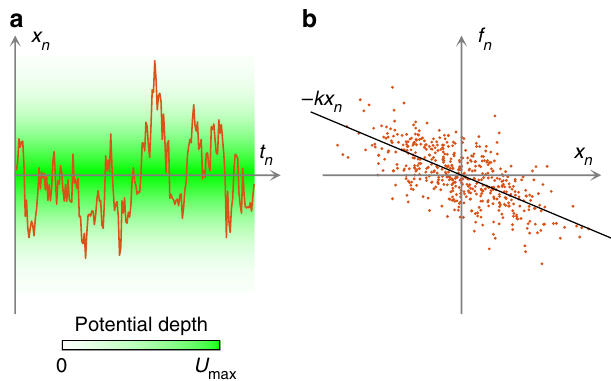
Fig. 1 Force reconstruction via maximum-likelihood-estimator